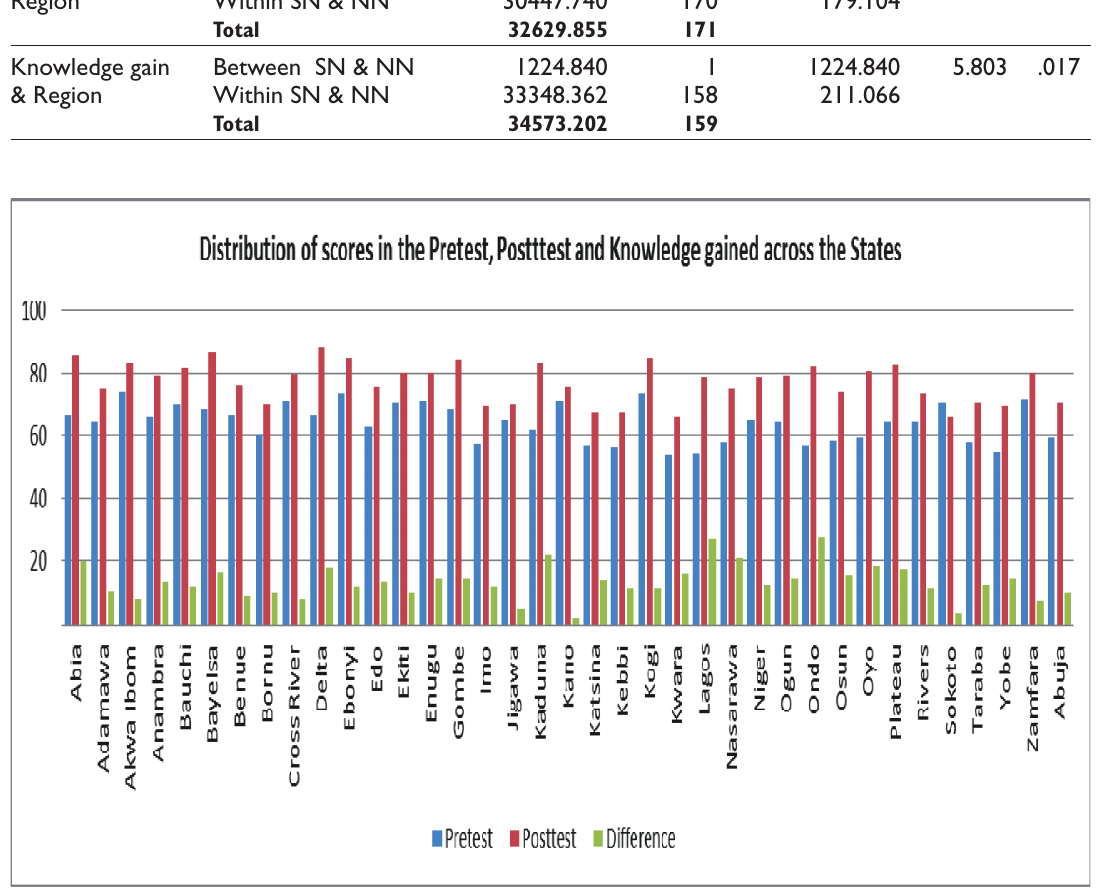
Figure 1. Distribution of scores in the pre-test, post-test and knowledge gained across the